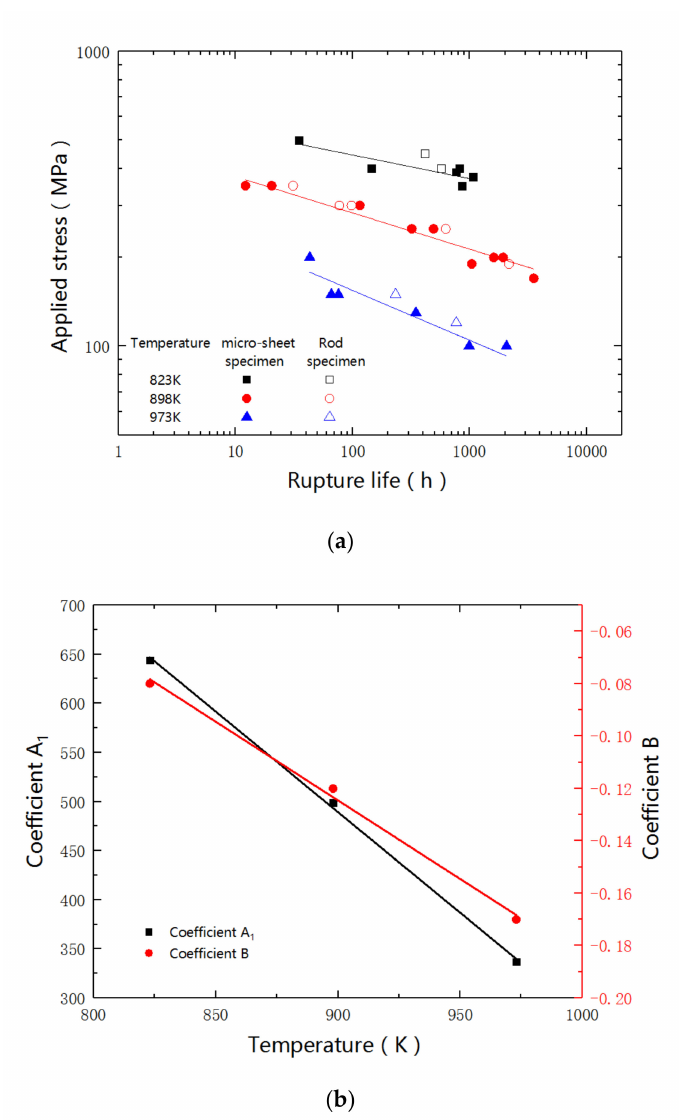
Figure 2. Creep test results: ( a ) data summary and comparison between the sub-sized sheet specimens with standard specimens; and, ( b ) dependence of coe ffi cients for estimating the rupture life on